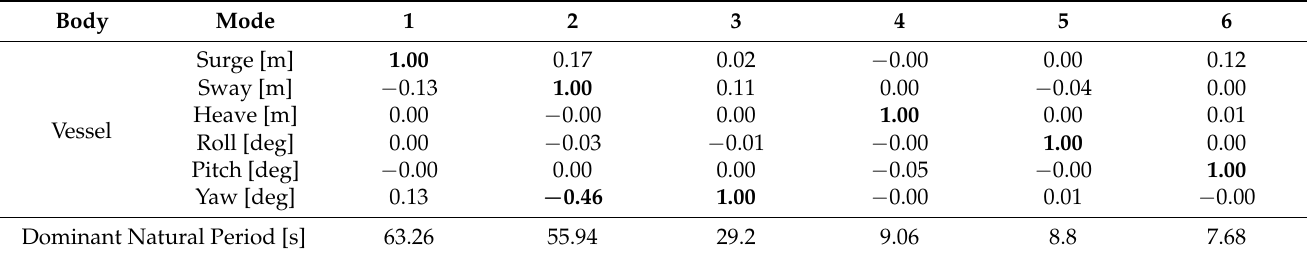
Table 7. Eigenvalues and natural periods of rigid body motions of vessel.